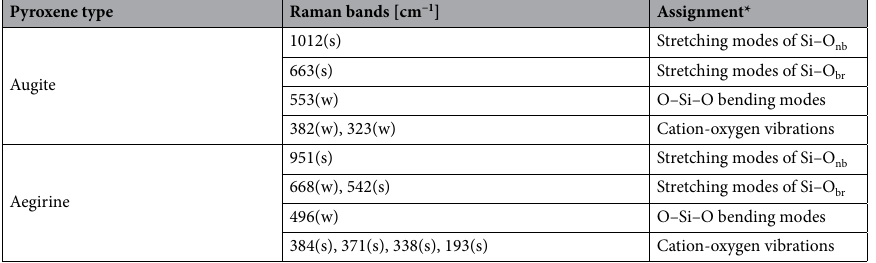
Table 3. Representative composition (EMPA) of greenish-gray luminescent primary plagioclase and secondary (weak-luminescent to dark-brown luminescent) replacive albite (based on 8 oxygen